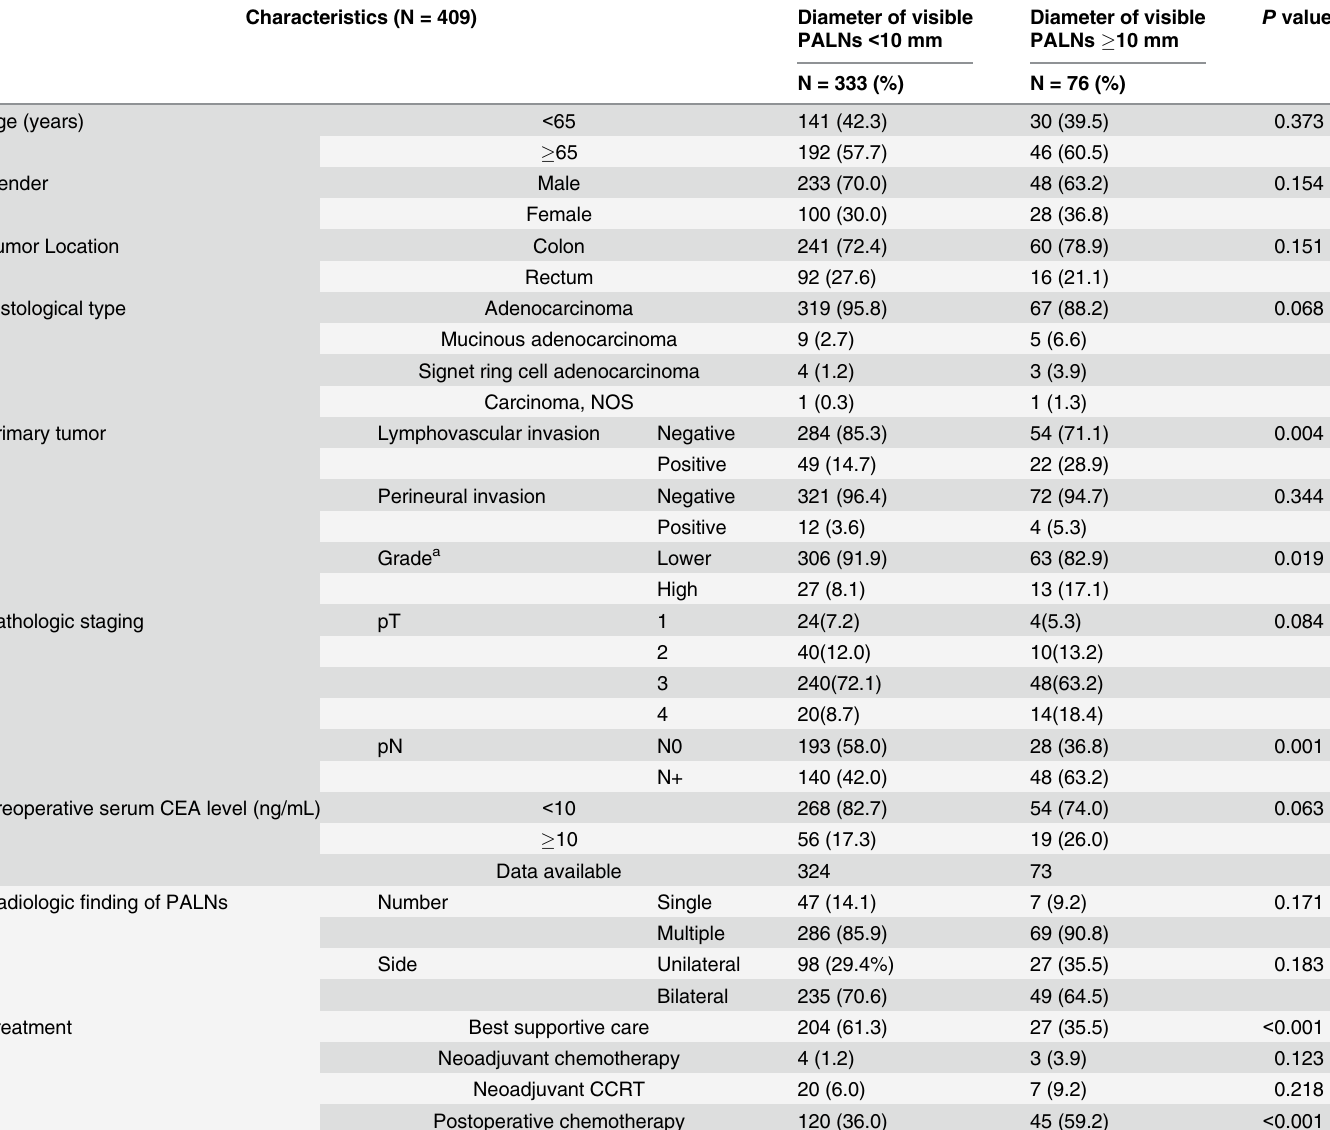
Table 3. Characteristics of patients with visible